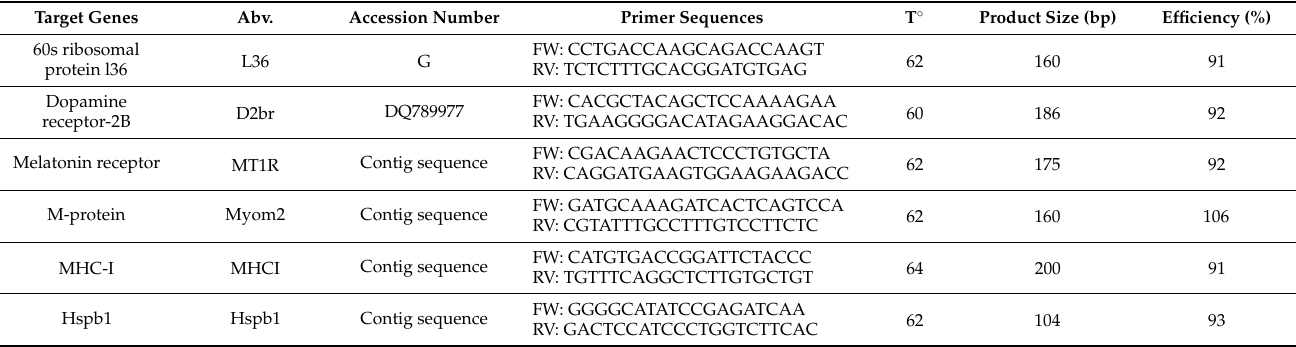
Table 2. Primers used for each target gene with Abv: abbreviation; G: sequence obtained from the A. anguilla genome [60,61]; T ◦ : annealing temperature and bp: base